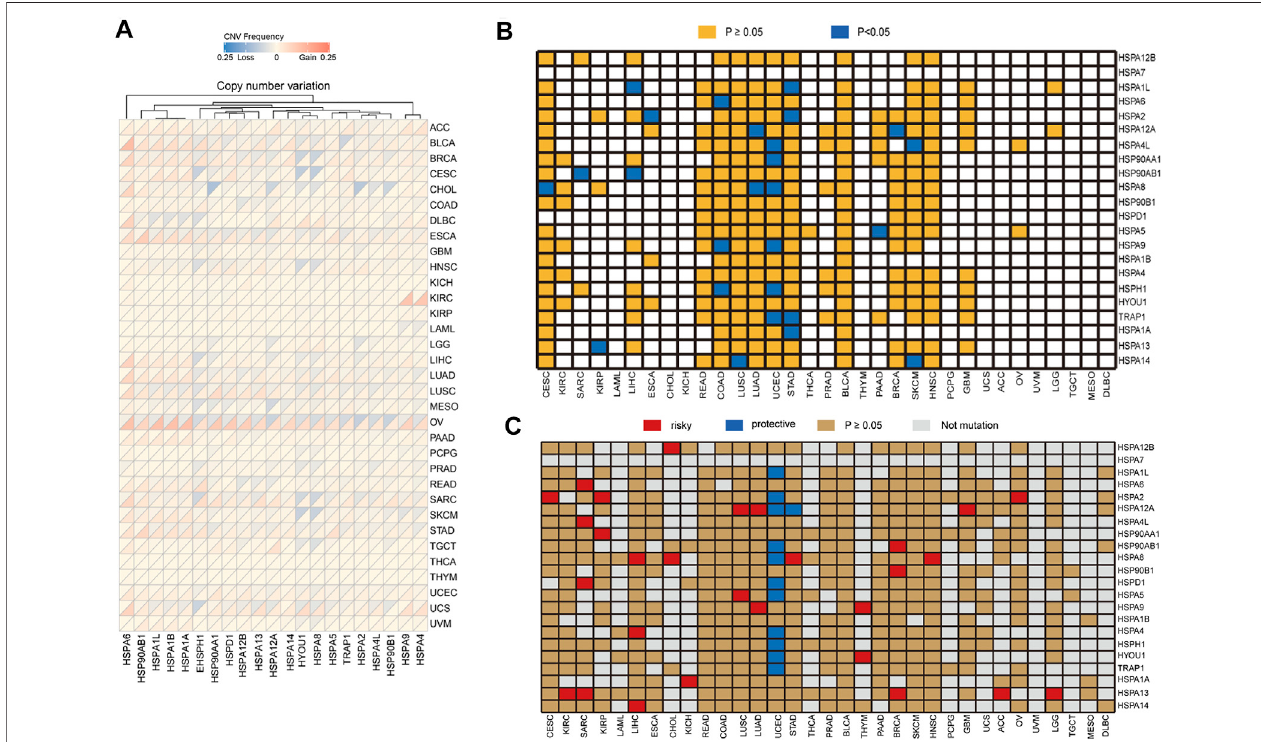
FIGURE 7 | Copy number variation of HSPs and the correlation of their variation with expression and prognosis. (A) Copy number variation frequency of HSPs in across different cancer types. (B) Association of HSP mutations with expression. Orange color represents p ≥ 0.05, blue color represents p < 0.05. (C) Correlation between HSP mutations and prognosis in different cancer types. Red color represents a worse prognosis, blue color represents a better prognosis and brown color represents p ≥ 0.05. HSPs, heat shock